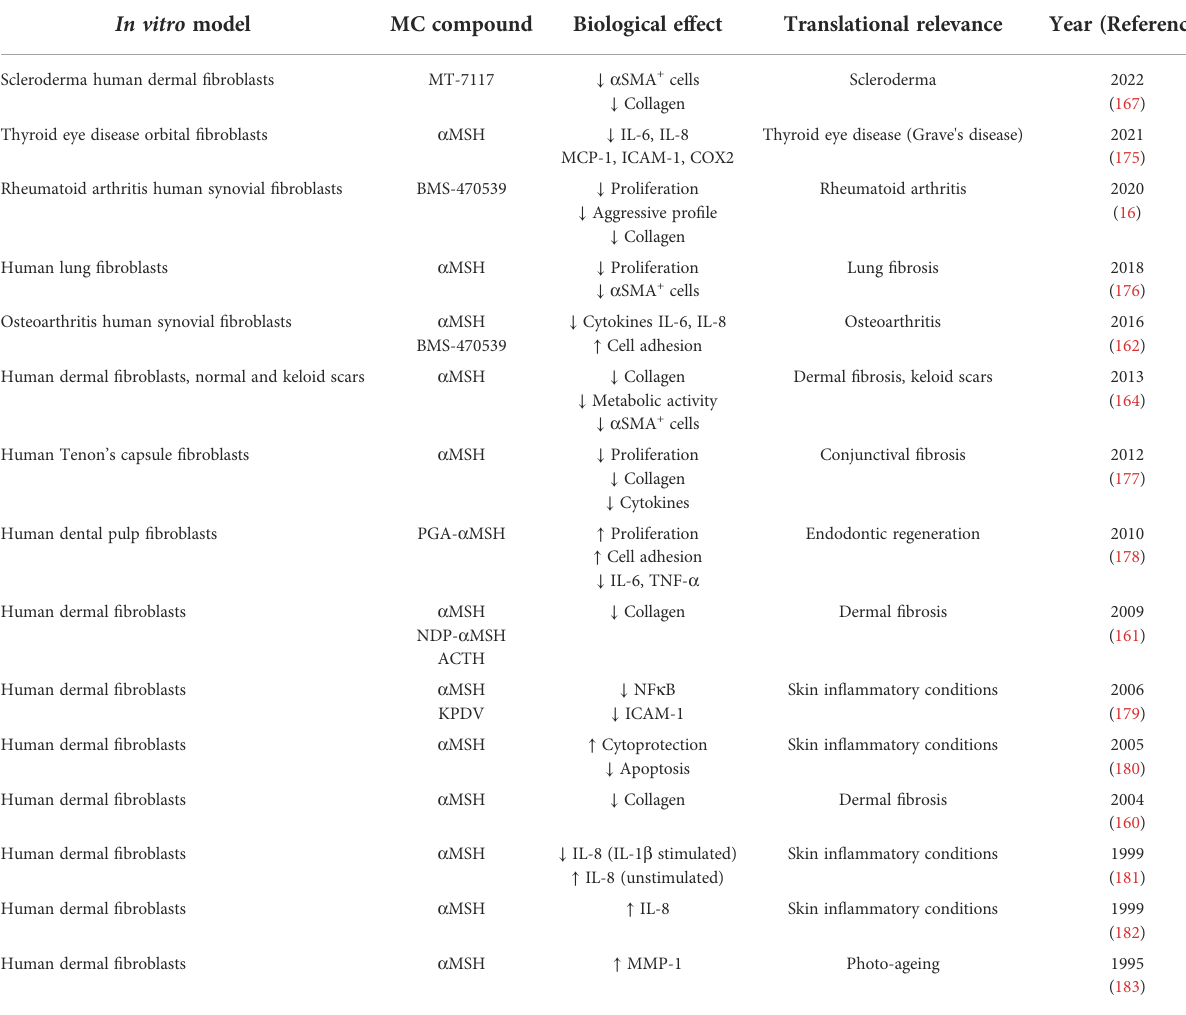
TABLE 1 Testing of melanocortin drugs using in vitro models of fi broblast activation. In vitro